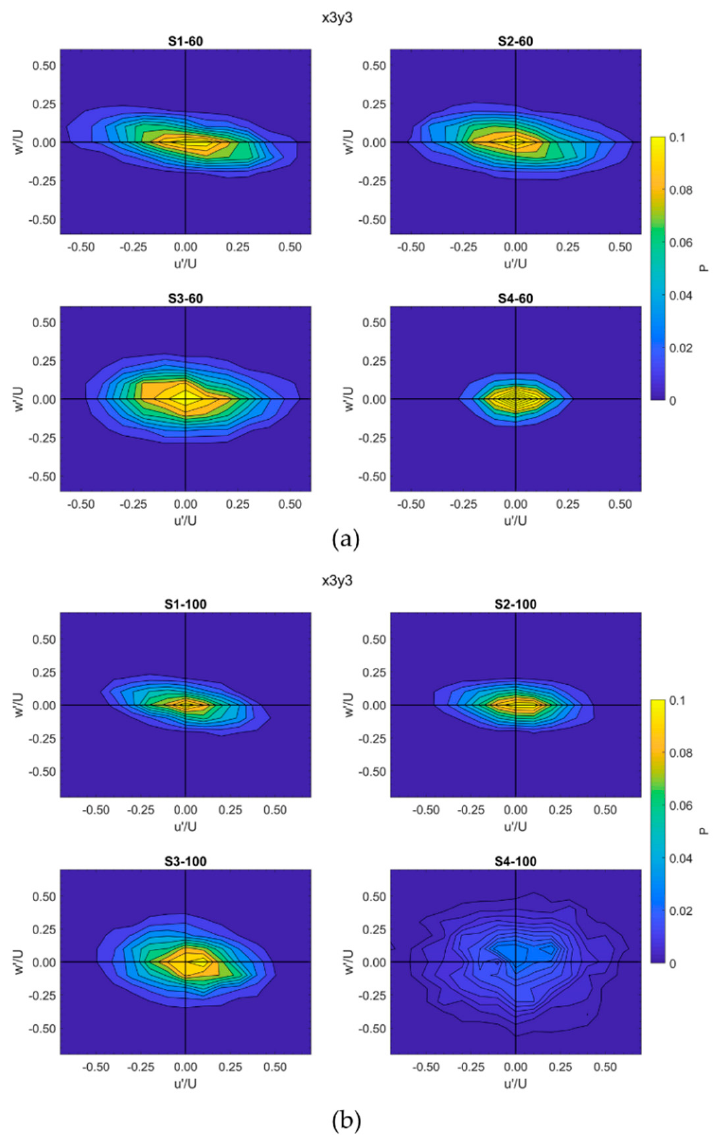
Figure 8. Joint frequency distribution of normalized 𝑢’ and 𝑤’ at point X3Y3 at ( a ) 60 L/s flow rate, ( b ) 100 L/s flow rate.